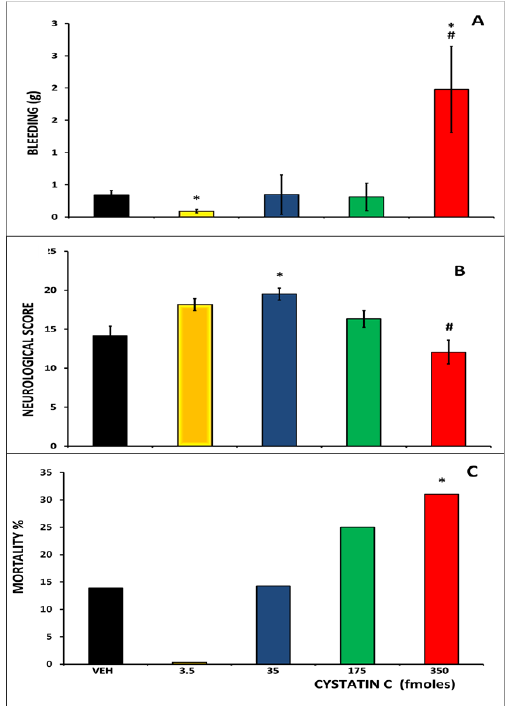
Figure 2. Effect of CC administration before TBI on bleeding, neurological score and mortality. ( A ) Bars represent mean ± SEM of bleeding (g) measured 15 min after TBI. * p < 0.05 vs. veh, # p < 0.05 vs . all other groups; Kruskall Wallis and Mann Whitney test; ( B ) Bars represent mean ± SEM of neurological scores obtained 24 h after TBI. * p < 0.05 vs. veh, # p < 0.05 vs. CC 35; Kruskall Wallis and Mann Whitney test; ( C ) Bars represent the mortality percentage eight days after TBI. * p < 0.05, Chi square